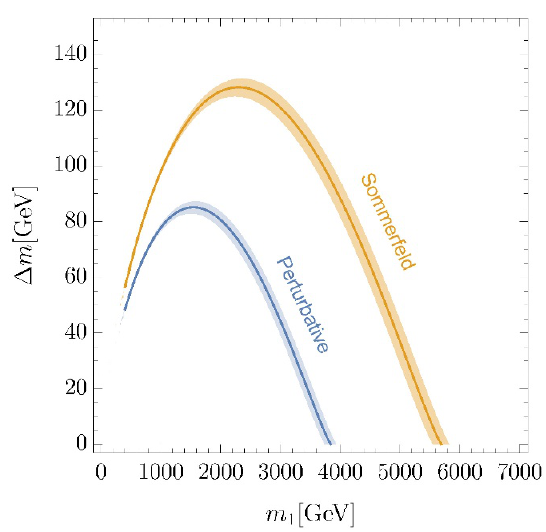
Figure 1 . Contours corresponding to the measured relic abundance (cid:10) h 2 = 0 : 1194 together with its 3- (cid:27) bands, in the case of domination by QCD processes. The perturbative result and the result including Sommerfeld enhancement are both shown. Note that part of the parameter space is already excluded by LHC searches, as explained in section 3.3 and shown in (cid:12)gure